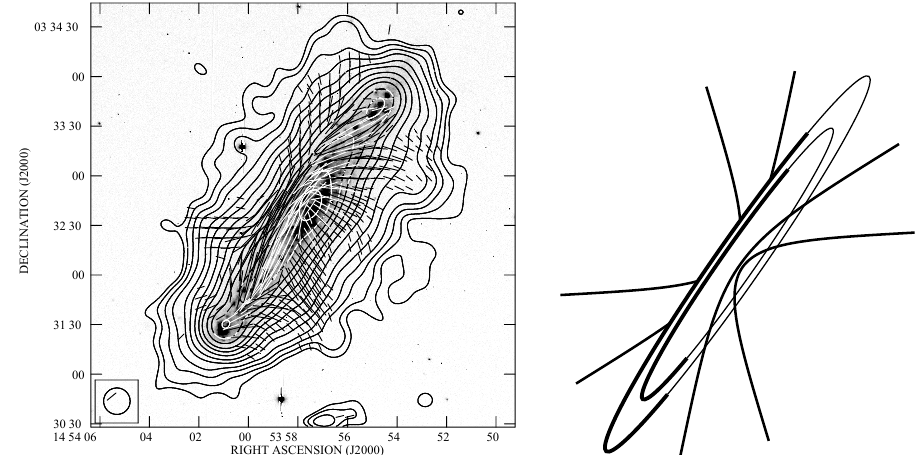
Figure 2. Total intensity contours map ( left ) with apparent magnetic field orientation at 4.8 GHz of NGC 5775 (from the VLA with a resolution of 16 (cid:48)(cid:48) HPBW) overlaid on an H α image and sketch ( right ) of a possible regular magnetic field configuration in the disk and in the halo for NGC 5775